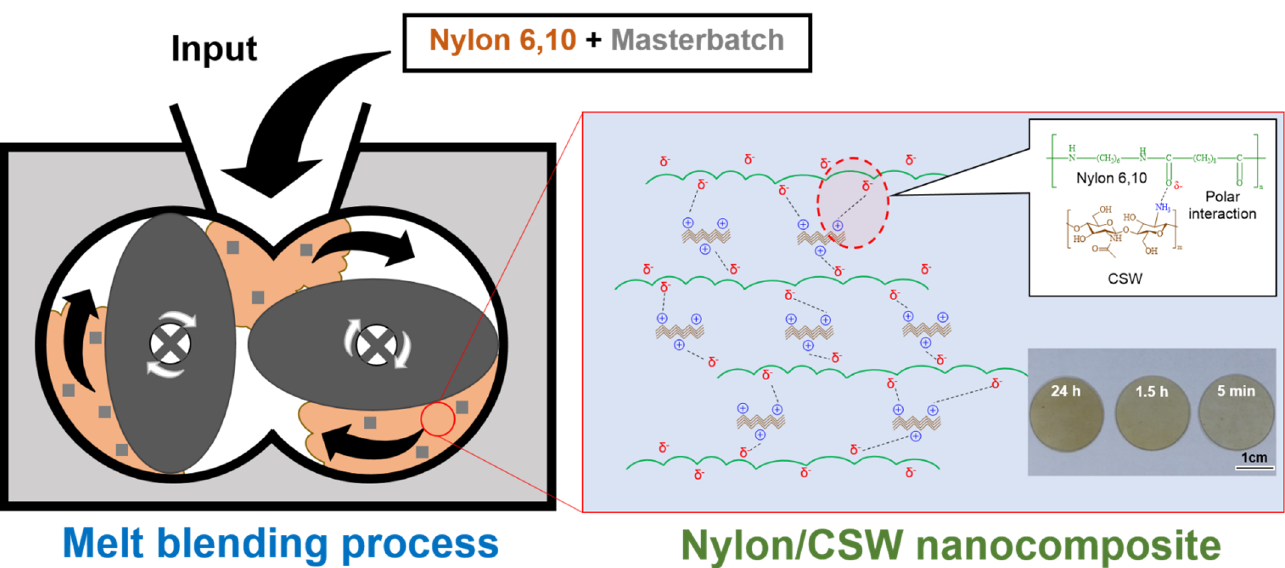
Figure 1. Preparation of nylon/chitosan nanowhisker (CSW) nanocomposite by melt blending.